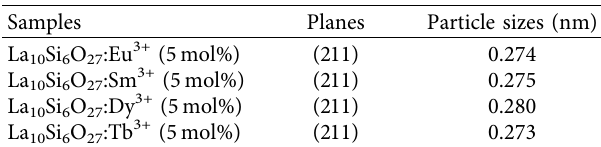
Figure 1: PXRD patterns of La -5mol %) nanophosphors. Table 1: Estimated particle size (nm) of La NPs for (211) plane.